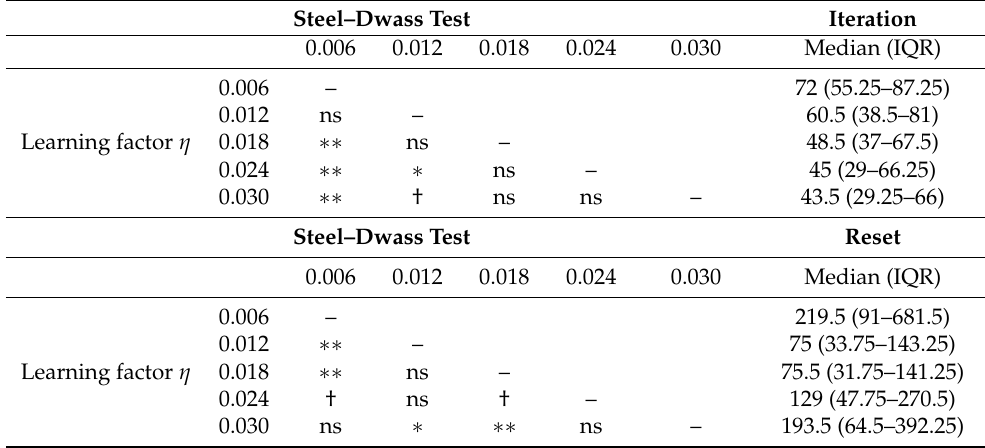
Table 2. Learning characteristics of the QNN concerning the learning factor.